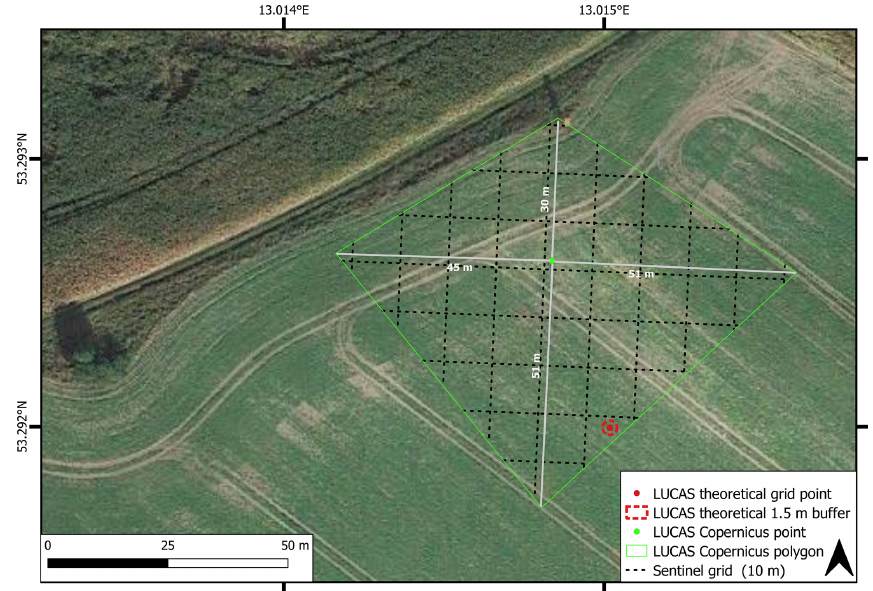
Figure 1. Building the Copernicus polygon geometry (example for point ID 45223358). The collected Copernicus variables (Table 2) are used to build the geometry of the Copernicus polygon. As the LUCAS theoretical point is inside the Copernicus polygon, the LC legend of the LUCAS theoretical observation (here B32 – rape and turnip rape) could be inherited to the Copernicus polygon (B3 – non-permanent industrial crops) as described in Sect. 4. The background RGB imagery is obtained from map data ©2019